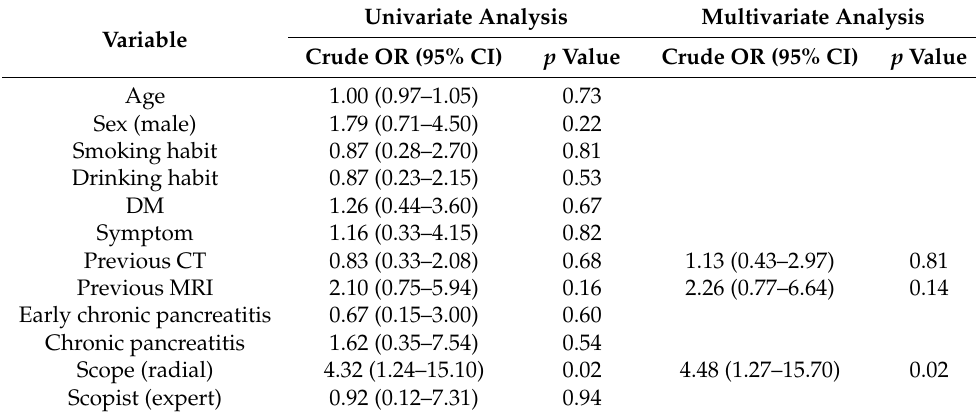
Table 3. Univariate and multivariate conditional logistic regression analysis of indirect findings.